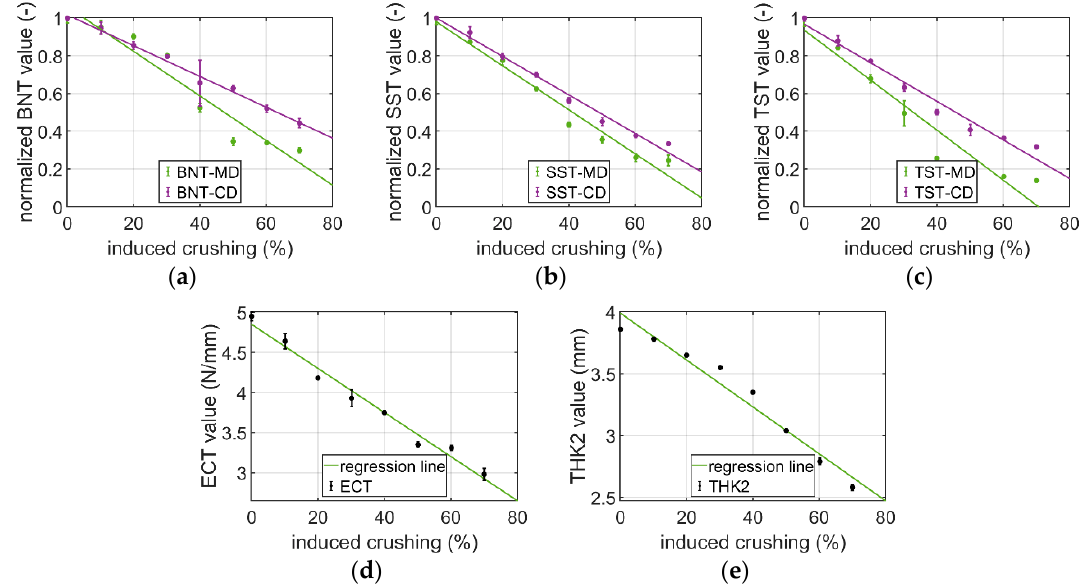
Figure 12. The decreases in measured values for C ‐ 340 corrugated cardboard in: ( a ) BNT; ( b ) SST; ( c ) TST; ( d ) ECT and ( e ) THK2.